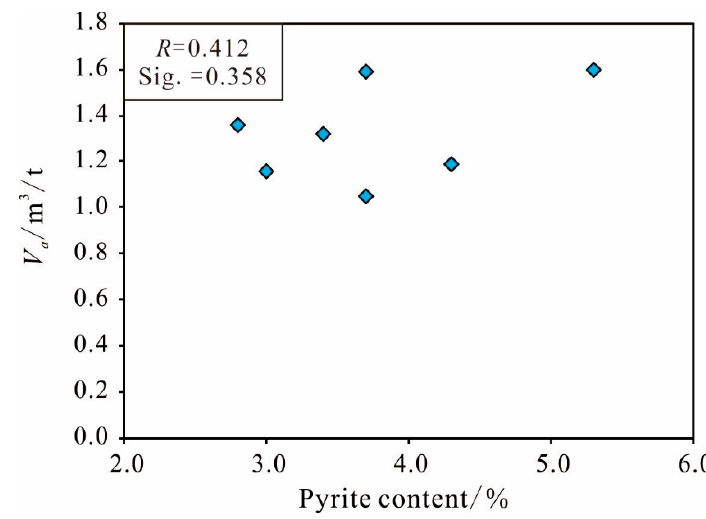
Figure 15. No obvious relationship between V a and the pyrite content.